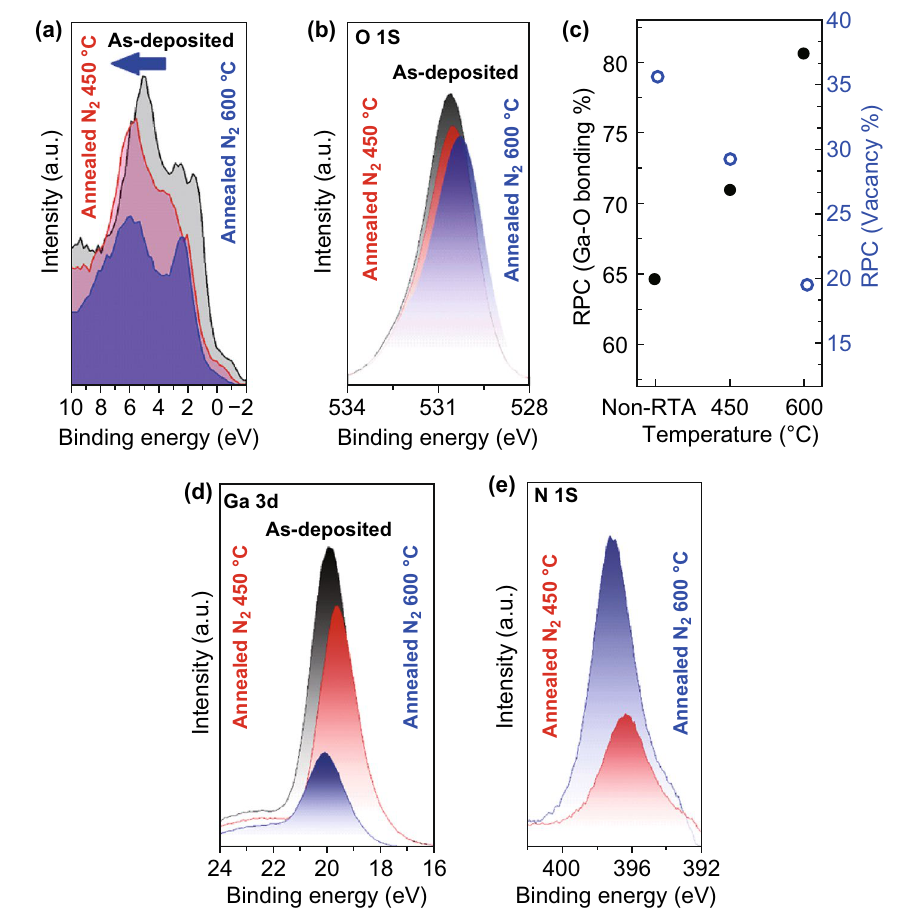
Fig. 4 XPS core-level spectra and VBM of N 2 -doped Ga 2 O 3 films. a RTA process is resulted in the alteration of bandgap alignment in gallium oxide films where a higher RTA temperature in N 2 atmosphere was accompanied by the increase in VBM. b Analytical analysis of O1s XPS characteristics of samples, c variation of percentage of Ga–O bonding and oxygen vacancy in RTA samples. d XPS characteristics of Ga3d and e N1s in RTA